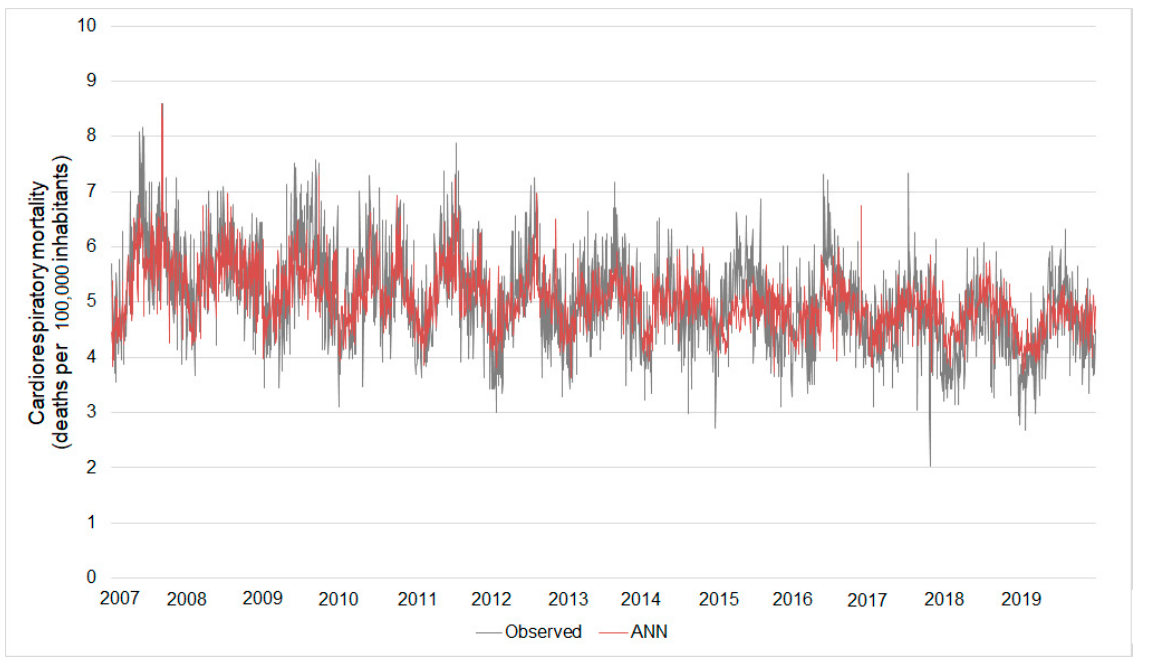
Figure 7. Real daily cardiorespiratory mortality versus that estimated by the Model III ANN. Results considering the ANN build from the dry season